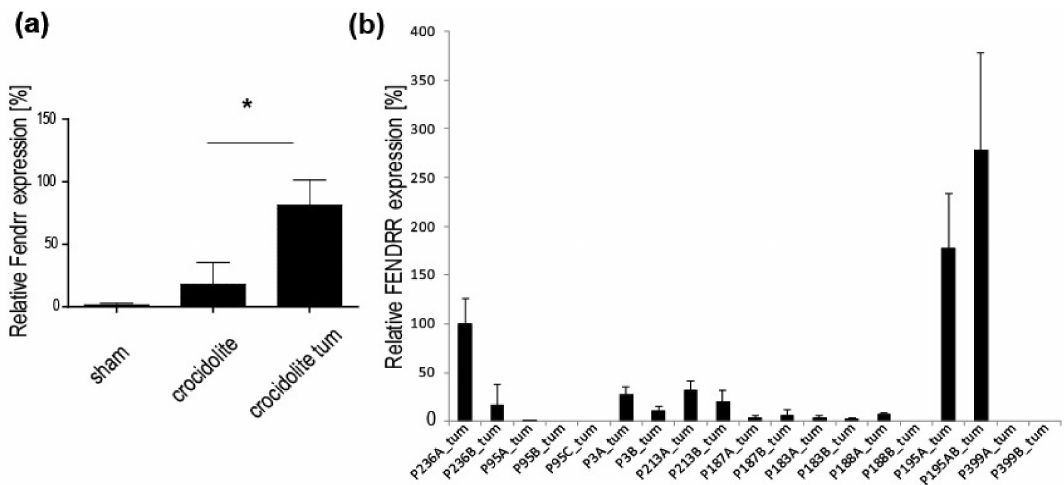
Figure 2. Fendrr is overexpressed in mice mesothelioma and associates with epithelial histotype commitment in human mesothelioma. ( a ) q-PCR of Fendrr expression was performed in sham, crocidolite-exposed mice without malignant tumors. Mean ± SE, N = 5–8 mice. * p < 0.05, Mann–Whitney test. ( b ) FENDRR gene expression analysis in tumor samples from nine patients for whom tissue is available at different time points during the progression of the disease. Mean ± SD, N = 3.